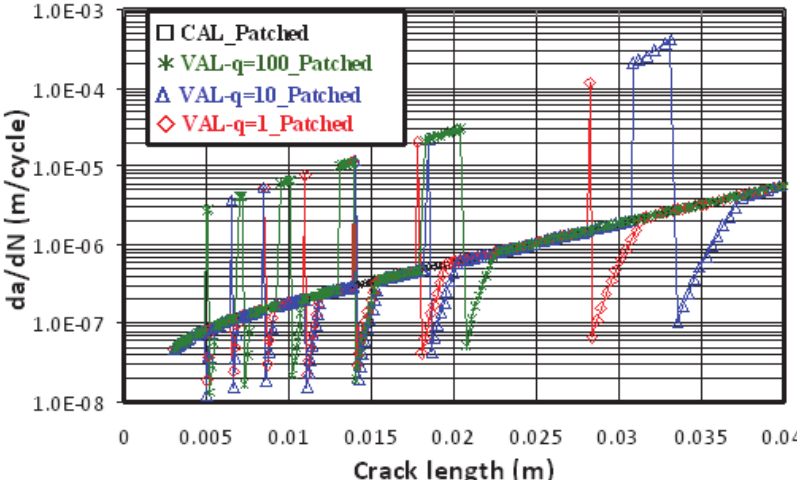
Figure 12: Influence of band overloading parameter “q” on crack growth rates of crack patch repair at ORL=2.4. C